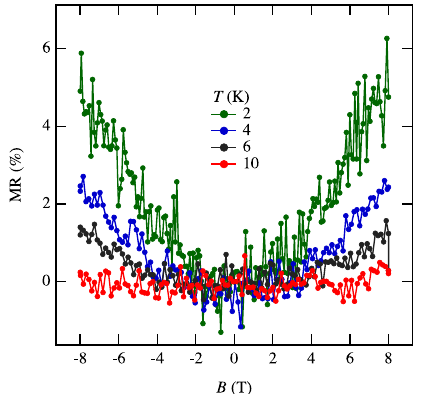
Figure A3. ( a )Temperature dependence of MR as a function of magnetic field at 10.5 GPa (sample 8). ( b ) Enlarged view of low magnetic field region of MR as a function of magnetic field and tem- perature at 10.5 GPa.